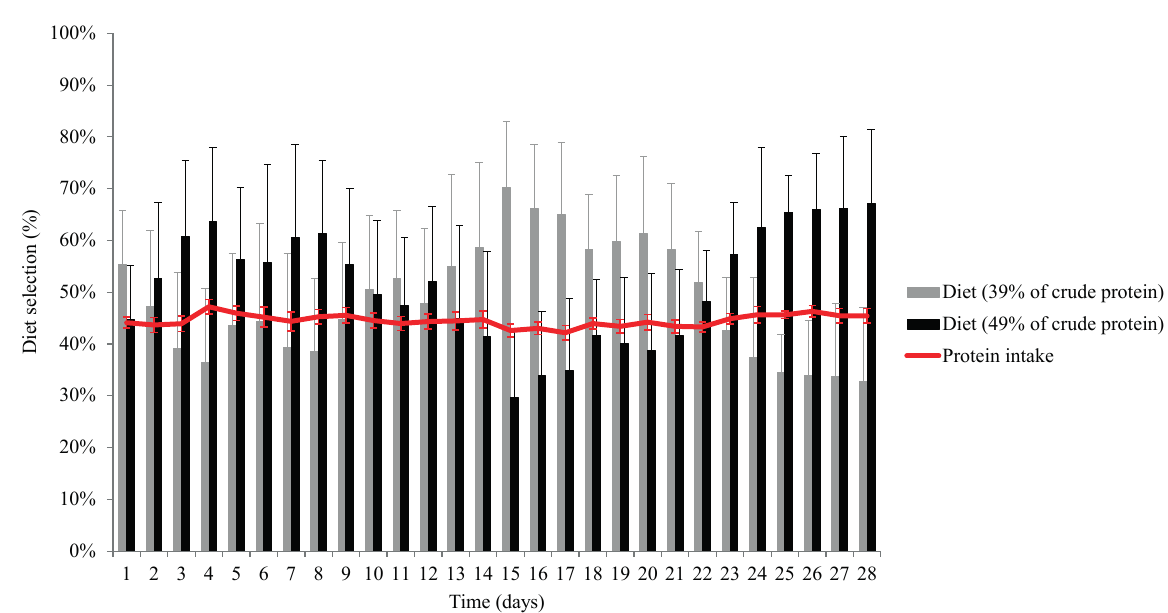
Figure 3 - Daily evolution of experimental diets selection (39% and 49% crude protein) and protein intake. Values of diets selection with asterisk are significantly different, ANOVA, P < 0.05,